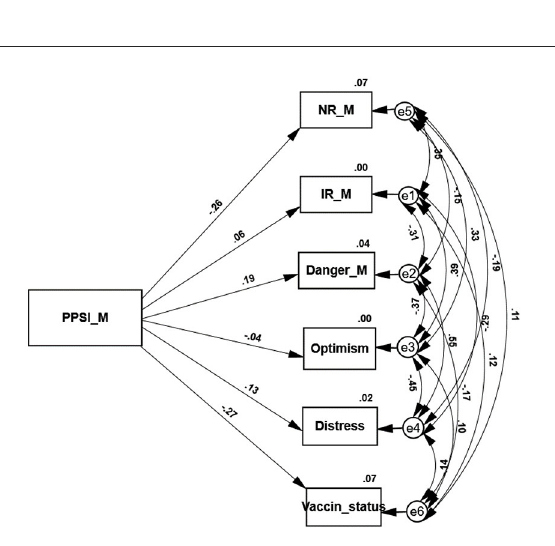
FIGURE2 A path analysis of the variables predicted by the PPSI score of the Arab